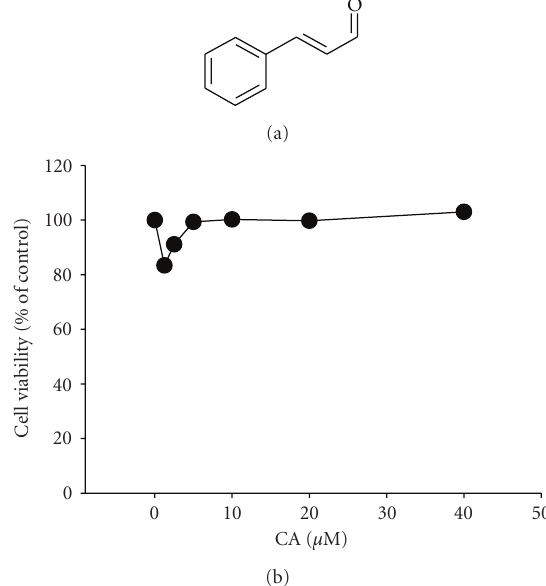
Figure 1: E ff ect of CA on the viability of RAW264.7 cells. (a) Chemical structure of CA. (b) The viability of RAW264.7 cells was determined under the same conditions by MTT assay after 24 hour